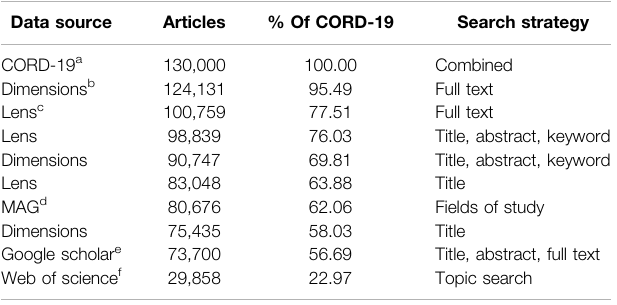
TABLE 2 | A simple comparison between different data sources on the search query used for this study as of September 5,